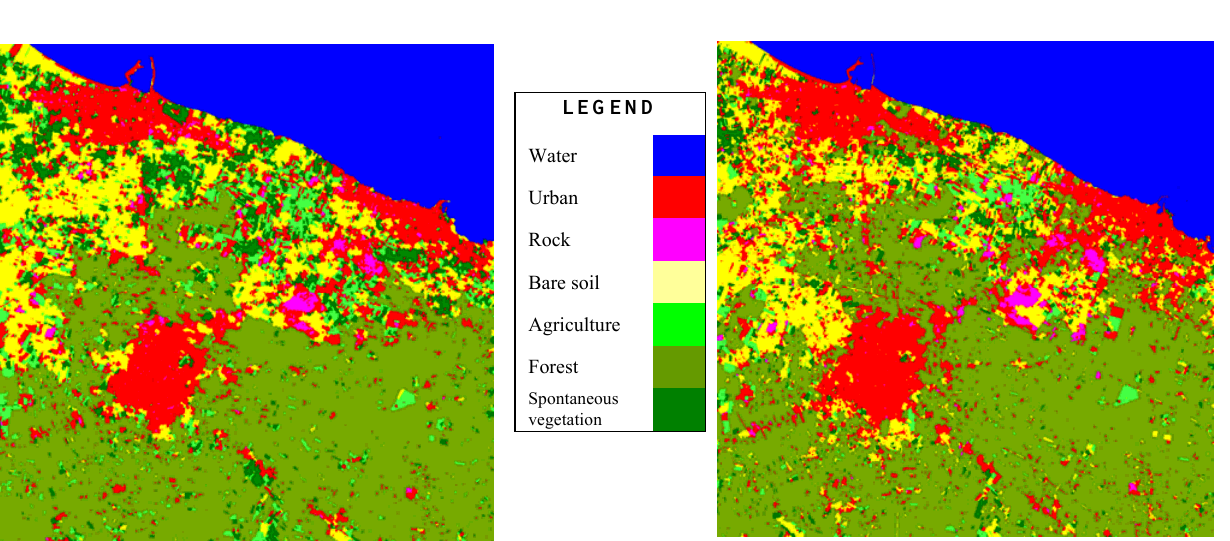
Figure 5. LC classes after Class-oriented classification on the ASTER data subsets of 24 June, 2003 (left) and 14 July, 2007